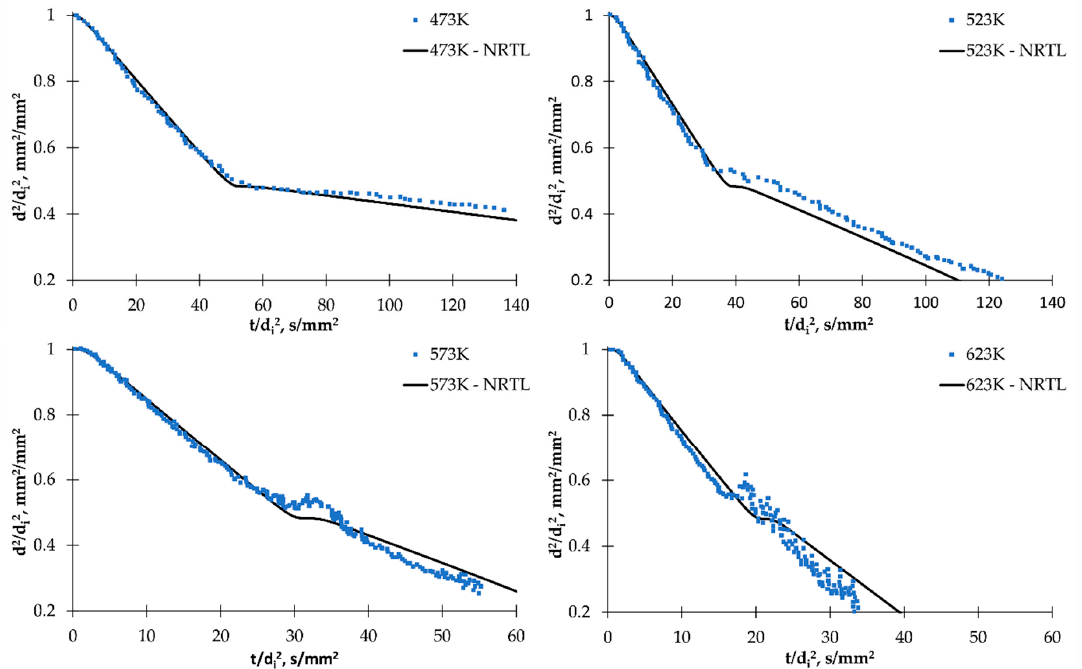
Figure 7. Evolution of square droplet diameter: results comparison (black line—model, blue points— literature date from [18]). Catalysts 2020 , 10 , x FOR PEER REVIEW